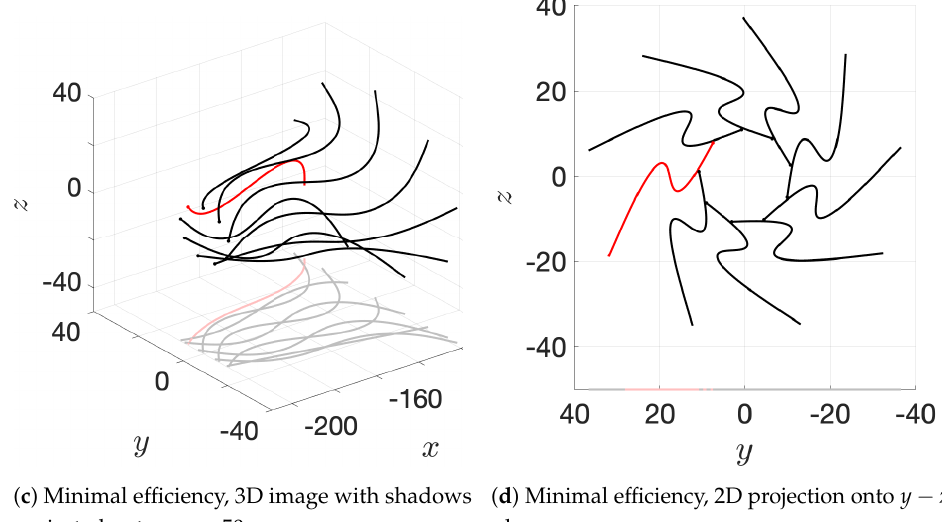
Figure 13. Snapshots of flagellar configurations for the radial simulation from Figure 4b, for both maximal and minimal efficiencies observed. One flagellum is highlighted in red for visual emphasis of the geometry. See Supplemental Material Movie S2 for all configurations over